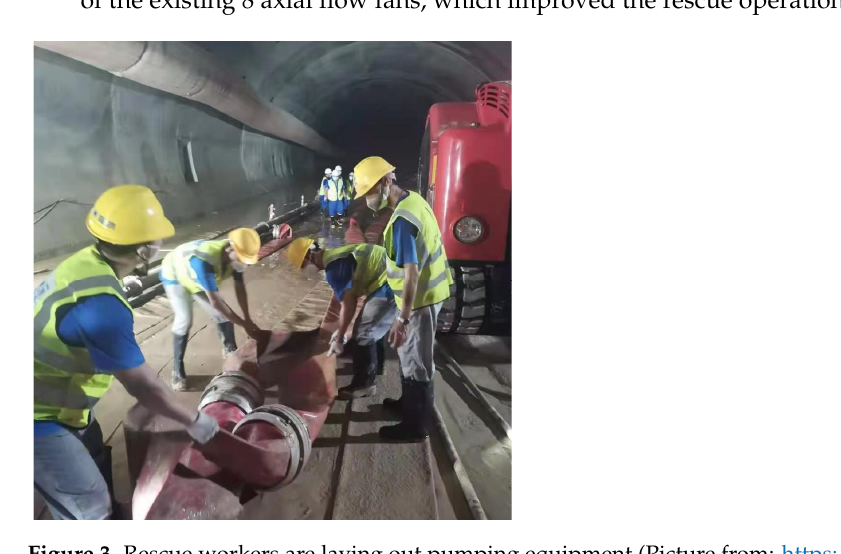
Figure 2. Zone water level in the tunnel after water inrush accident: ( a ) The transport port is at the lowest water level (https://www.guancha.cn/politics/2021_07_17_598831_s.shtml, accessed on 18 January 2022); ( b ) The water in the middle reached rescuers’ waists (https://www.xian- jichina.com/news/details_275025.html, accessed on 18 January 2022); ( c ) The highest water level for rescue, where oxygen is scarce (https://www.thepaper.cn/newsDetail_forward_13726501, accessed on 18 January 2022).